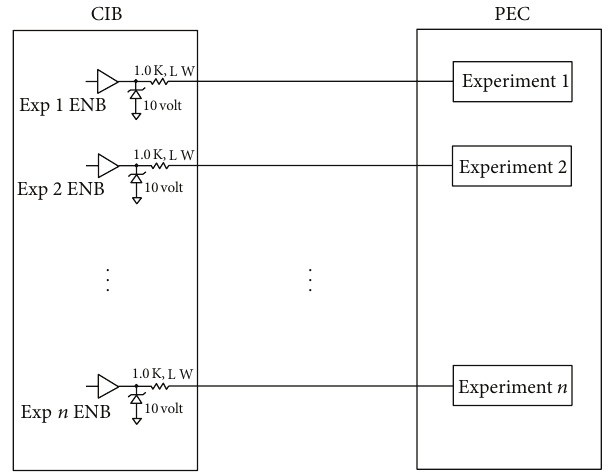
Figure 4: Schematic of the CIB enable lines for experiments onboard the Passive Experiment Containers (PECs). Current limit- ing resistors as well as voltage limiting Zender diodes to protect CIB enable circuitry from experimental failure are shown within the CIB (image courtesy of